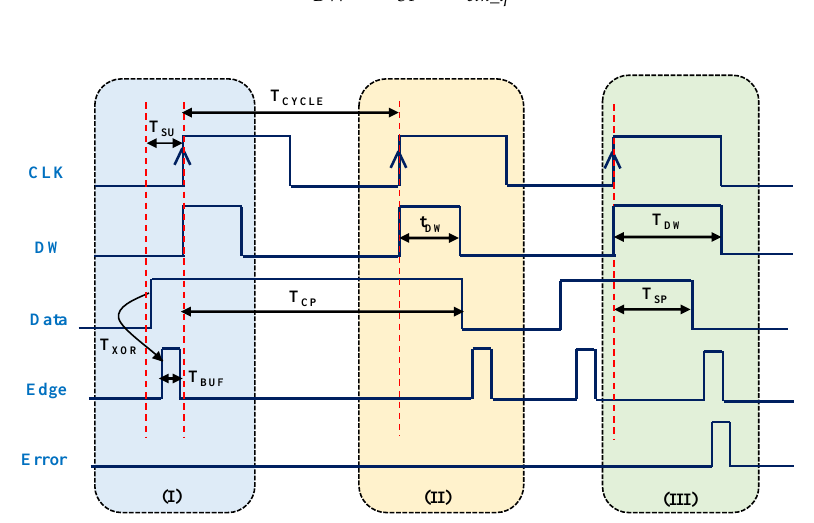
Figure 5. Three cases of having false error detections in the proposed